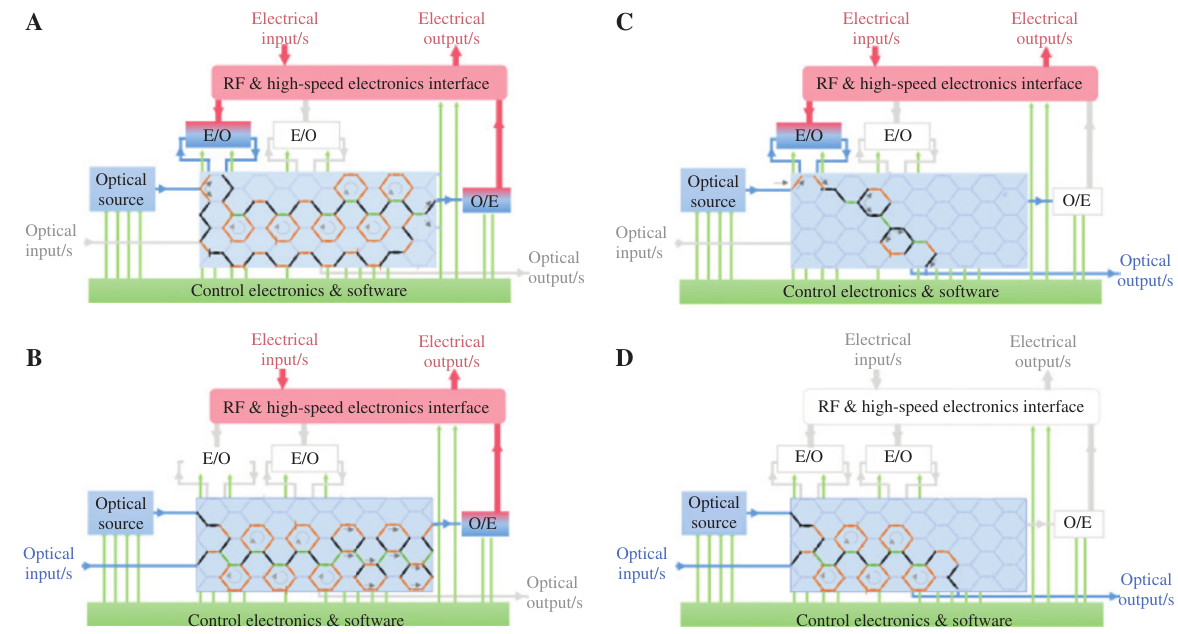
Figure 4: The four different alternatives for the operation modes of programmable multifunctional nanophotonics processor. (A) Electrical input/electrical output, (B) electrical input/optical output, (C) optical input/electrical output and (D)